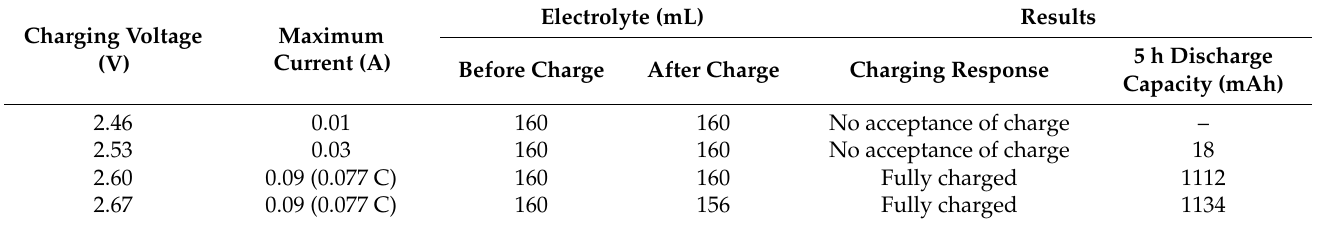
Table 7. Charging and discharging results for discarded cells.